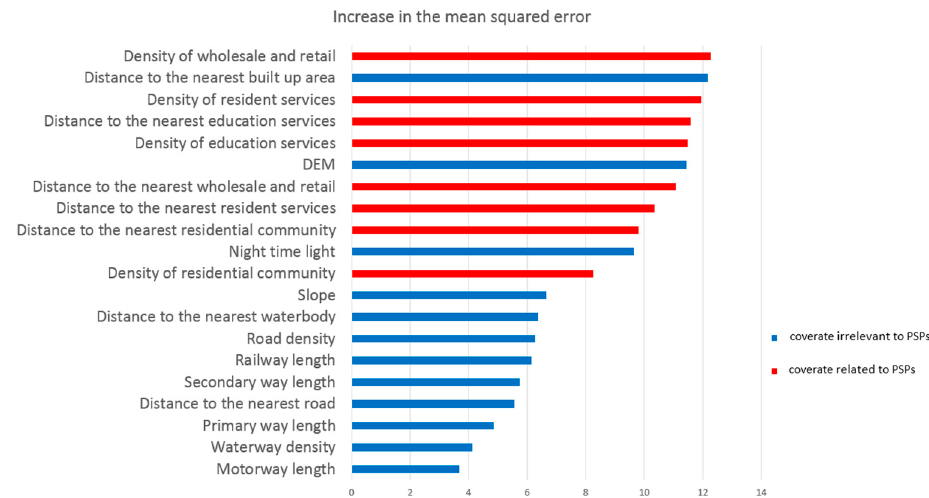
Figure 4. The value of the increase in the mean squared error (%IncMSE) for each covariate in the random forest model.